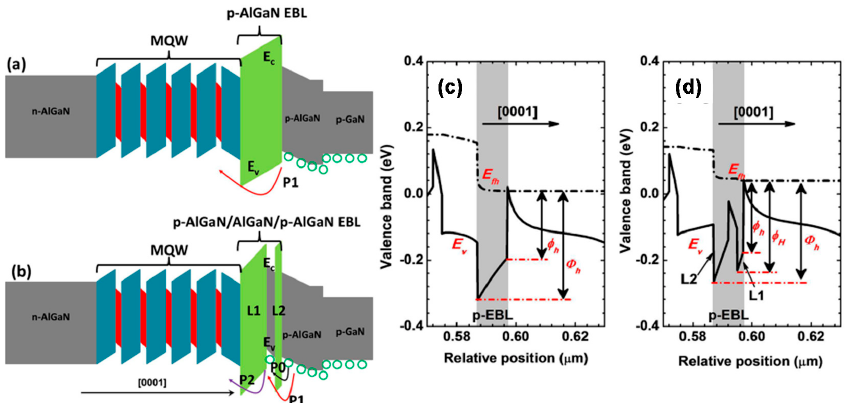
Figure 7. Schematic energy band diagrams for ( a ) Device A with the conventional bulk p-EBL and ( b ) Device B with the proposed p-EBL. Numerically calculated valence bands in the vicinity of ( c ) the conventional p-EBL for Device A and ( d ) the proposed p-EBL for Device B. In Figure 7a, P1 represents the hole transport by the thermionic emission. In Figure 7b, P0 denotes the hole transport by the intraband tunneling process, P1 and P2 mean the hole thermionic emission from the hole supplier into the thin AlGaN insertion layer and from the AlGaN insertion layer into the MQW region, respectively. Reproduced from Ref. [24], with the permission of American Chemical